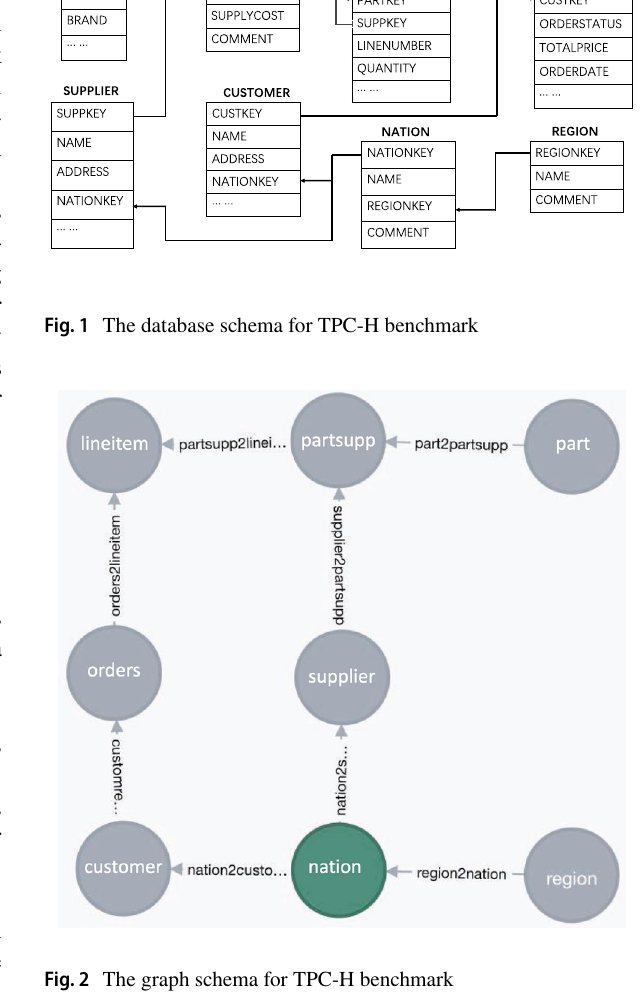
Fig. 2 The graph schema for TPC-H